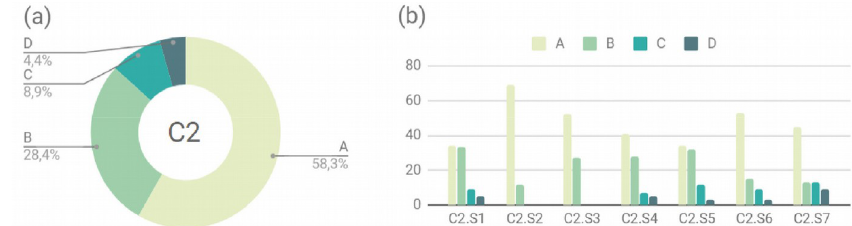
Figure 6. Student assessment of category C2. Satisfaction (a) as a whole and (b) for each question. Table 3 shows the coding of the statements